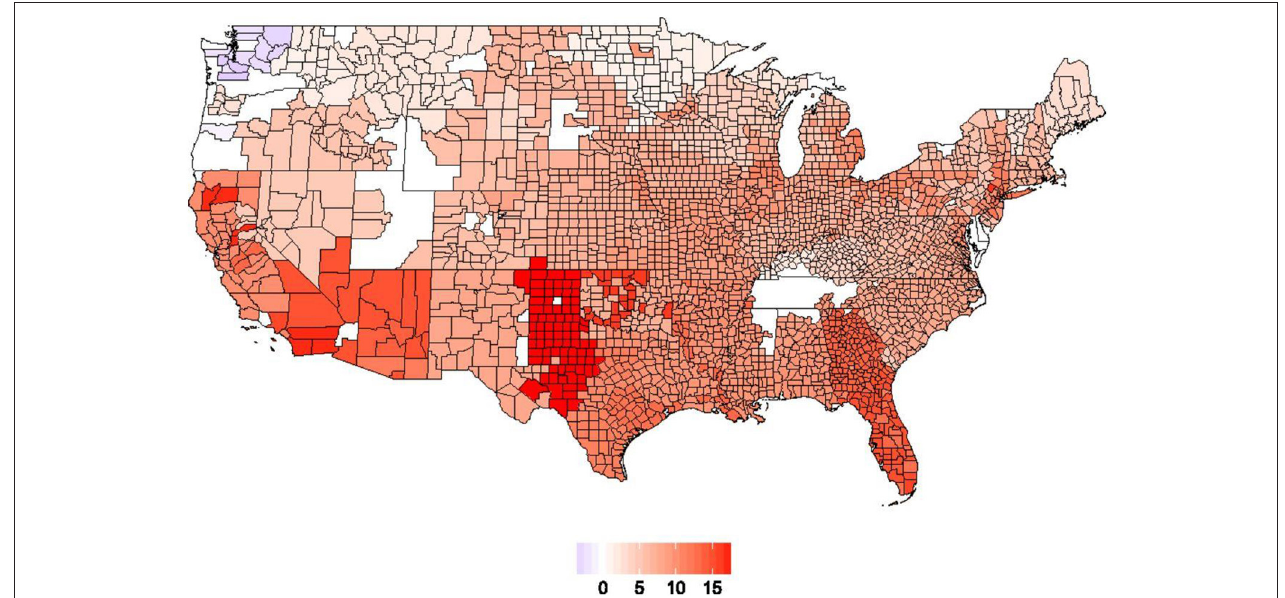
FIGURE 1 | Changes in Peak Load Under RCP8.5 Scenario Across the United States. Peak Load Varies Geographically, with the Largest Increases in the South and West. Coloring Reflects the Percentage Increases in Peak Load due to Temperature Rise by the End of the Century ( Auffhammer et al., 2017).